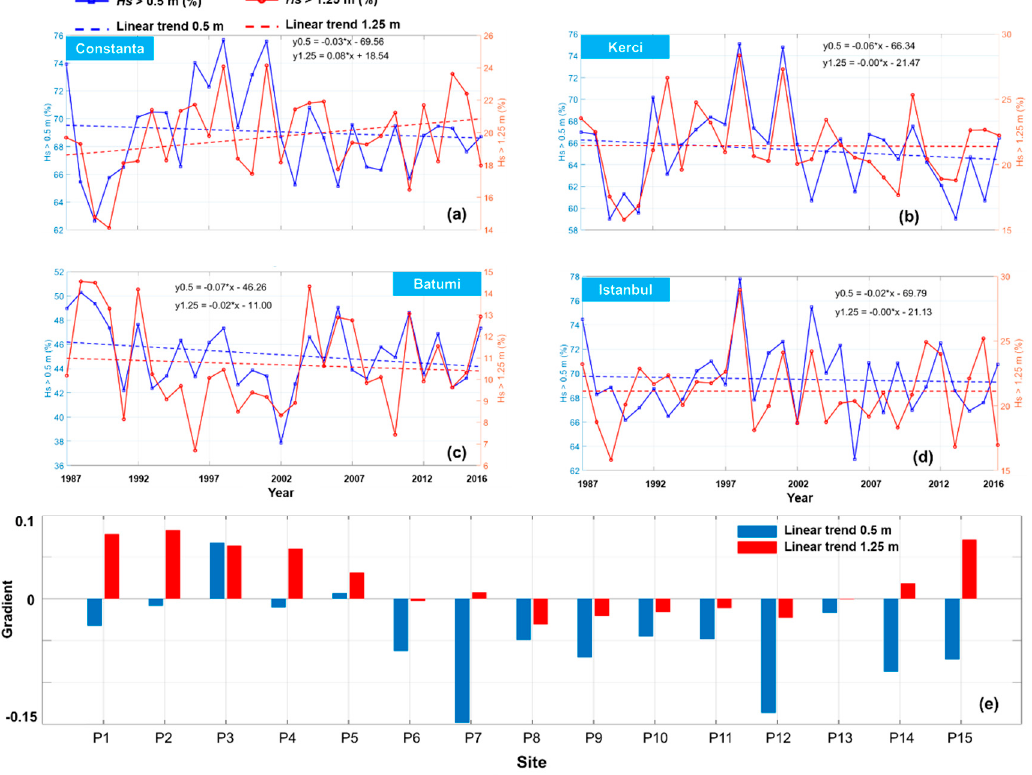
Figure 11. Inter-annual distribution of the Hs parameter, where: ( a – d ) evolution of the wave heights higher than 0.5 m and 1.25 m reported for the Constanta, Kerci, Batumi and Istanbul sites; ( e ) gradient distribution for all the reference sites.